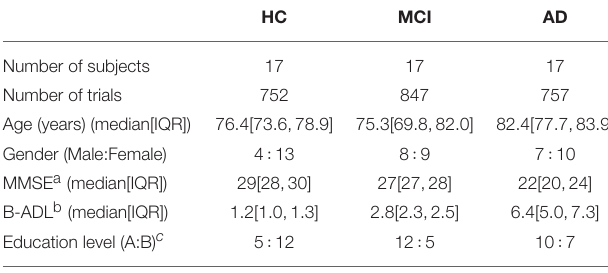
TABLE 2 | Socio-demographic and clinical data for each group in the test set. TABLE 1 | Socio-demographic and clinical data for each group in the training set. HC MCI AD HC MCI